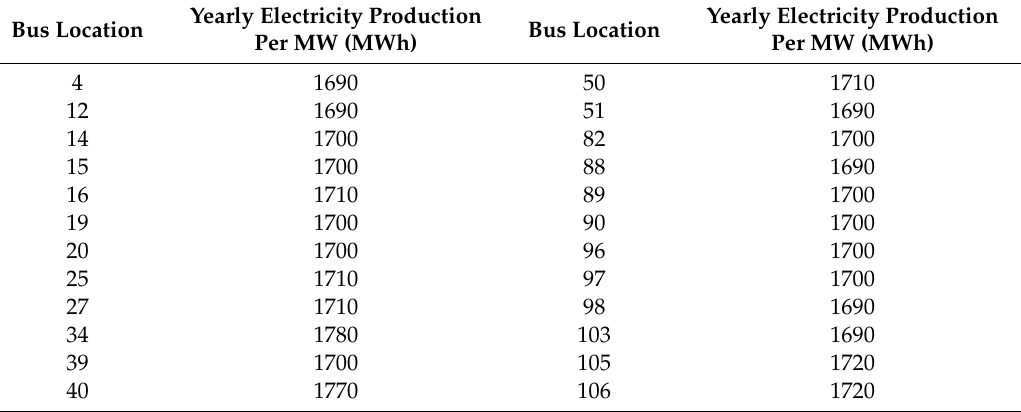
Table 4. Yearly electricity production per MW of the photovoltaic DG resource.